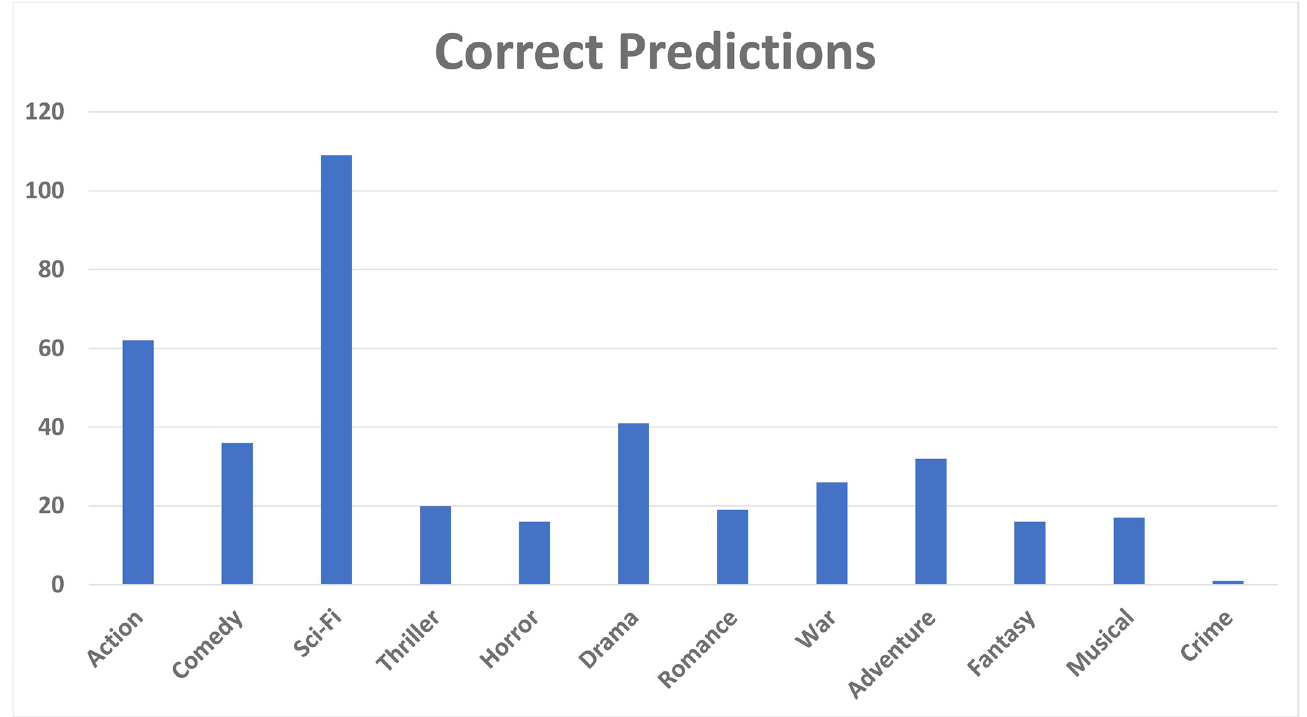
Fig 7. Correct predictions by